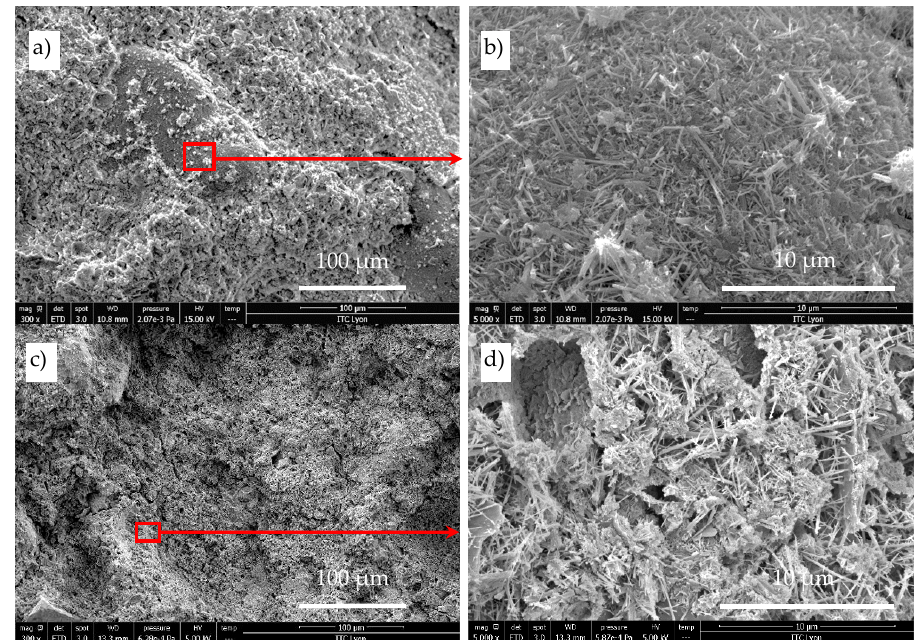
Figure 6. Microstructure by SEM on surface fractures of filler 15% ( a , b ) and copper slag bioleach residue 15% ( c , d ) after 28 days of hydration.